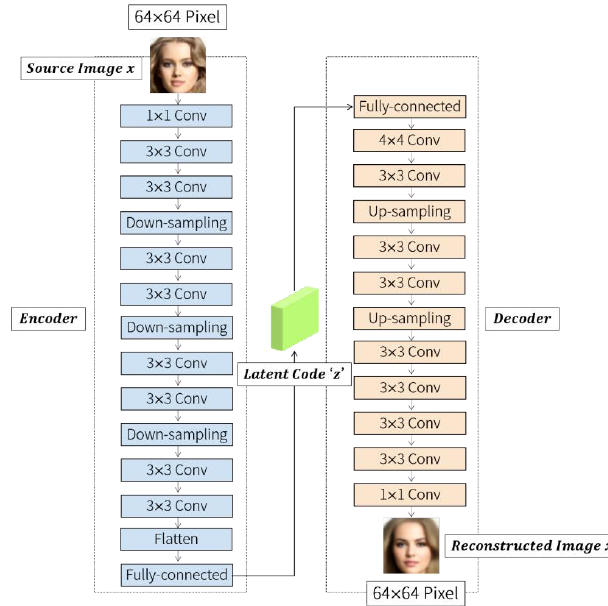
Figure 7. Discriminator structure of the proposed model.